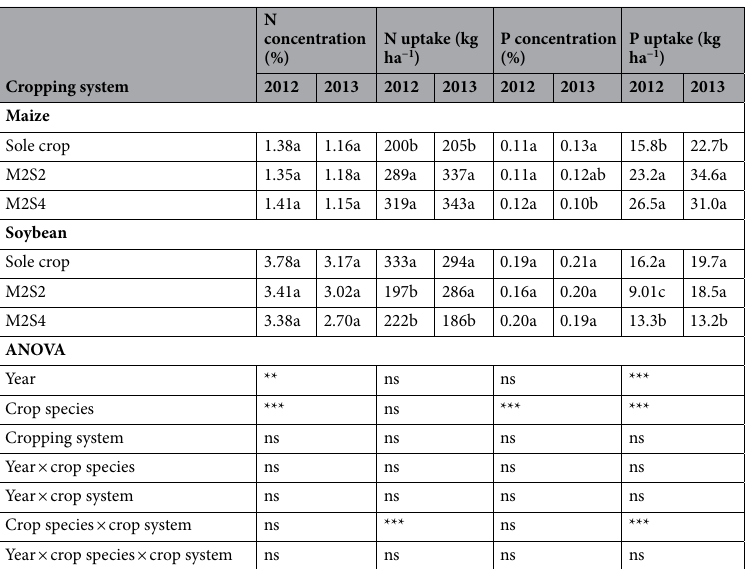
N concentration (%)